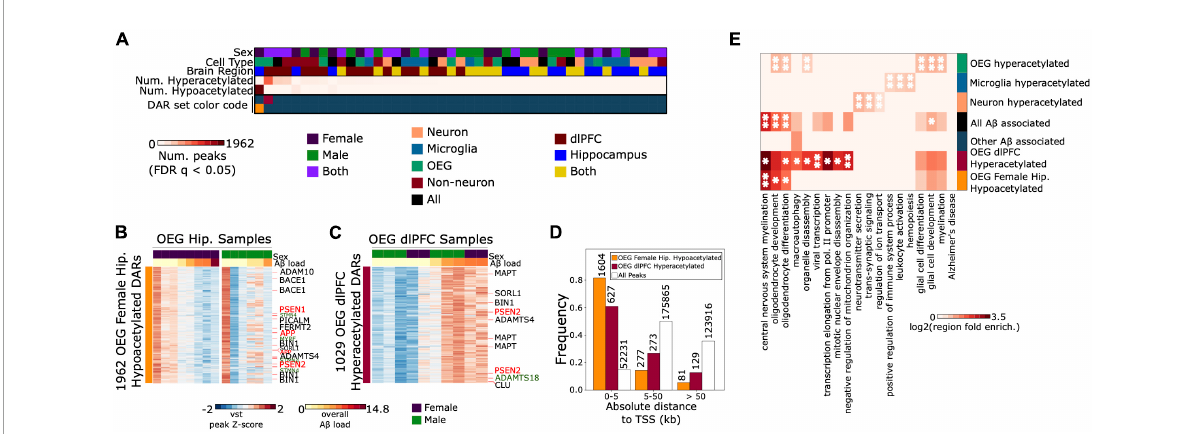
FIGURE3 OEG display the strongest acetylation differences associated with A β pathology, including peaks annotated to genes associated with EOAD and LOAD risk (A) . Heatmap displaying number of significantly hyperacetylated (log2fc > 0, FDR q < 0.05) and significantly hypoacetylated peaks (log2fc < 0, FDR q < 0.05) from each brain region, sex, and cell type-specific contrast (B) left: Heatmap of normalized acetylation levels at 1962 H3K27ac peaks that were significantly hypoacetylated in AD female hippocampus OEG samples. Rows represent the 1,962 DARs and columns represent hippocampal OEG samples. A β load for each sample is indicated at the top of the heatmap. Right: A heatmap of the 1,962 peaks in male hippocampal OEG samples is included for comparison. DARs annotated to EOAD and LOAD risk genes are labeled in red and black, respectively. Peaks near STMN4 and MYRF are annotated in green (C) . Heatmap of the 1,029 H3K27ac peaks that were significantly hyperacetylated in AD dlPFC OEG samples. Peaks annotated to EOAD and LOAD risk genes are labeled in red and black, respectively. The ADAMTS18 promoter-proximal peak is annotated in green (D) . Distance to TSS distribution of (i) 1,962 OEG female hippocampus hypoacetylated DARs, (ii) 1,029 OEG dlPFC hyperacetylated DARs and (iii) the full consensus set of peaks (E) . Enrichment heatmap of top gene ontology terms for 6 peak sets (1) 1,962 OEG female hippocampus hypoacetylated DARs (2) 1,029 OEG dlPFC hyperacetylated DARs (3) all other A β associated DARs (4) neuron, (5) microglia, and (6) OEG cell type-specific hyperacetylated peaks. Color intensity represents hypergeometric fold enrichment in number of peaks over background (full consensus peak set), ∗ indicates FDR q < 0.05, ∗∗ indicates FDR q <